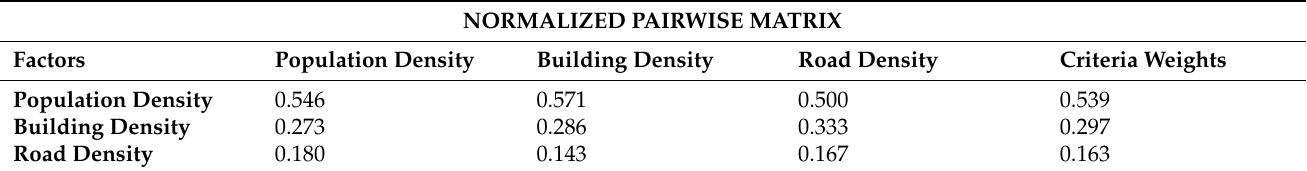
Table 4. Normalized pairwise matrix highlighting criteria weights used for vulnerability factors.